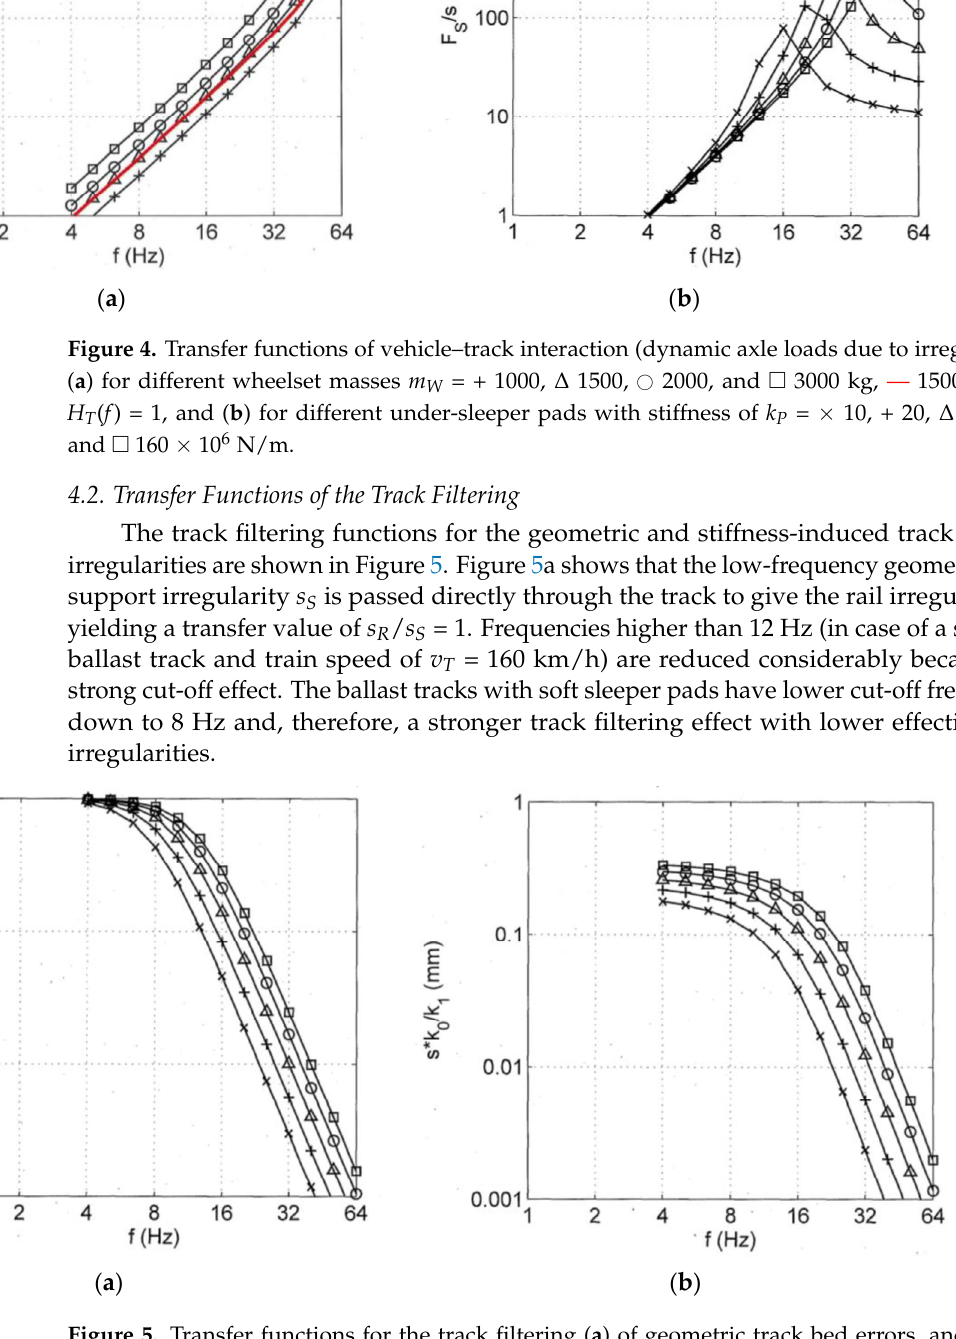
Figure 5. Transfer functions for the track filtering ( a ) of geometric track bed errors, and ( b ) of a stiffness variation, ballast tracks with different under-sleeper pads with stiffness of k P = × 10, + 20, ∆ 40, ○ 80, and □ 160 10 6 N/m.